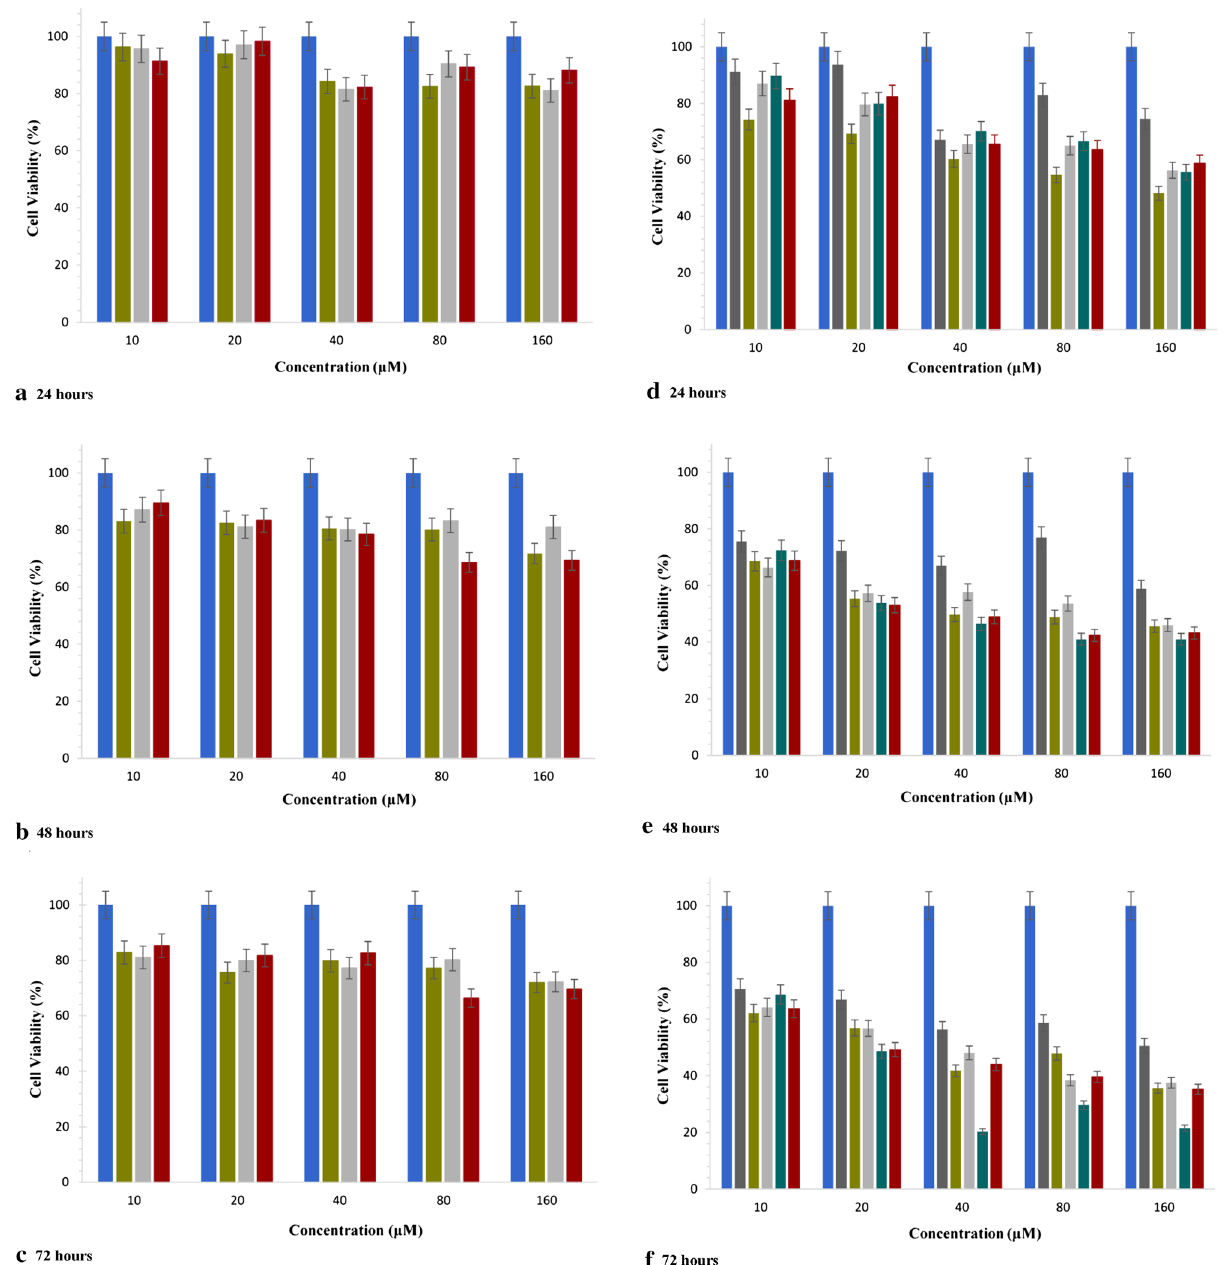
Figure 7. Treatment of hella cell with drug-free and CUR-loaded NG systems. Different colors were according to control (blue), free CUR (dark grey), reference sample (green), L-g-PNIPAM (gray), LNDNG number 3 (turquoise blue), and LNDNG number 2 (brown) respectively. Safety of drug-free samples ( A – C ) on viability of exposed cells were evaluated at three points of time (24, 48, and 72 h). Cytotoxic effects of CUR-loaded nanogel systems ( D – F ) on exposed cells were also